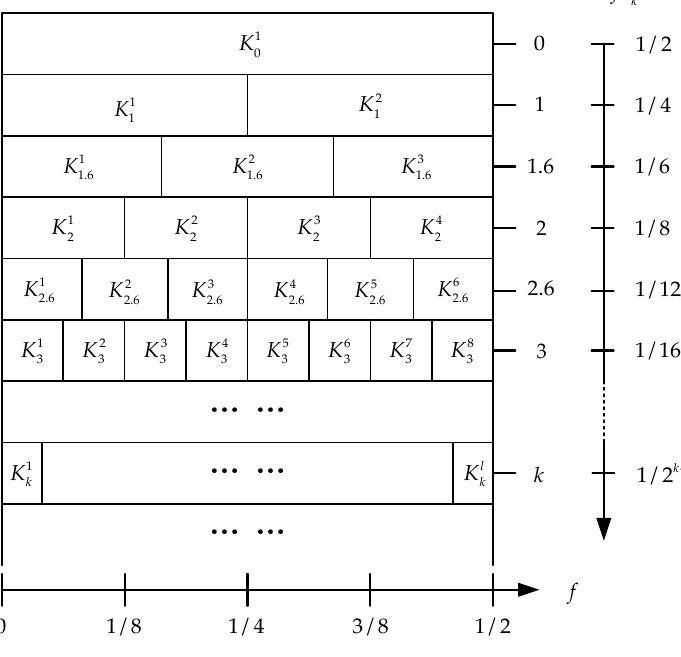
Figure 1. Paving of the original kurtogram proposed by Antoni [20].